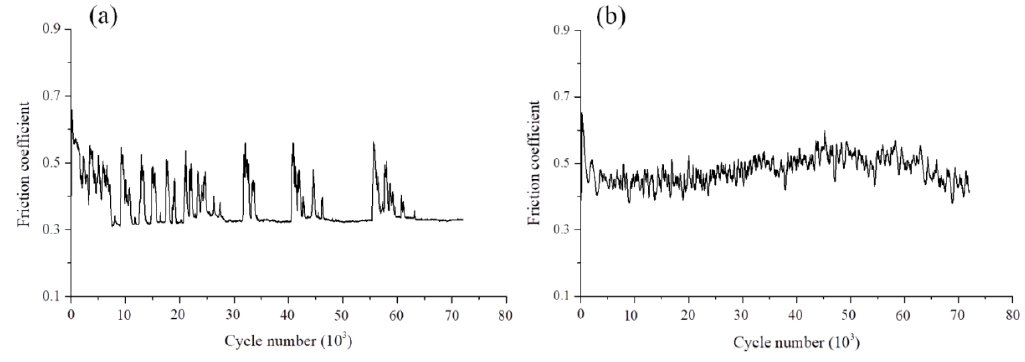
Figure 5. Evolution of friction coefficient under the load of ( a ) 35 N and ( b ) 70 N.